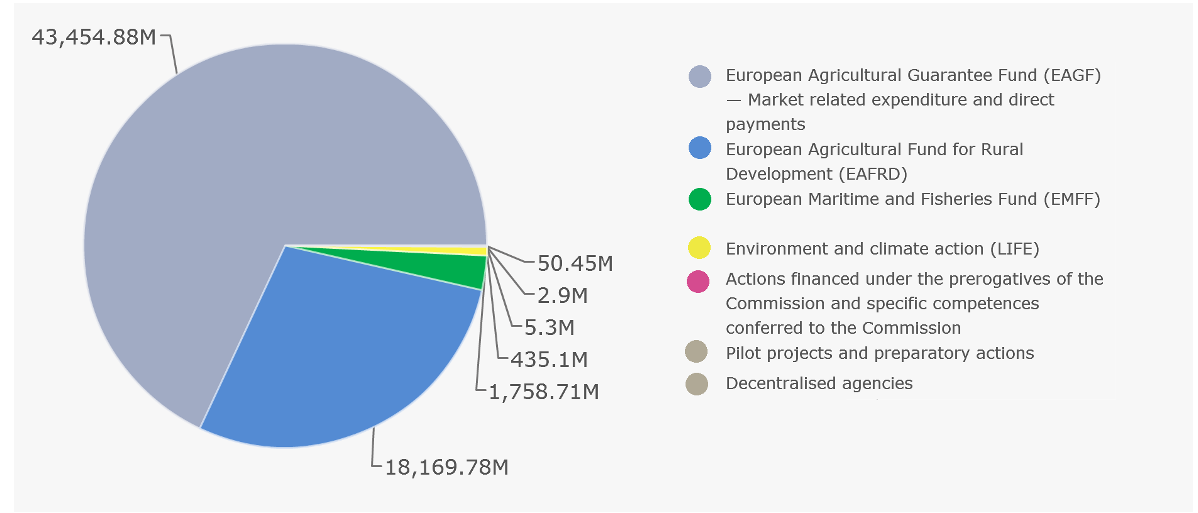
Figure 2. Sustainable growth: natural resources budget for the EU 2015